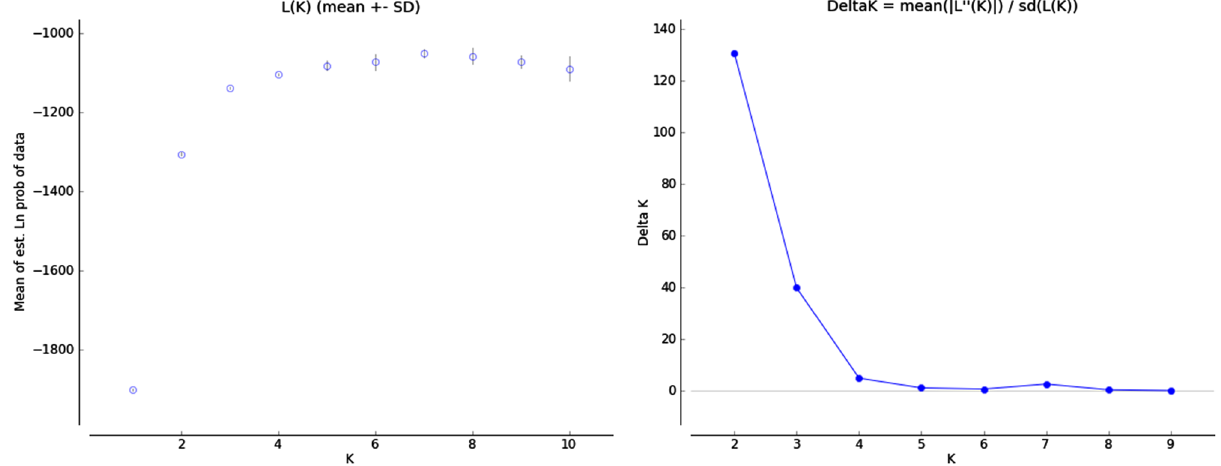
Figure 1. Modeling of cluster number for sweet potato using STRU CTU RE. L( K ) (left) and Delta K (right) were calculated in accordance with the method of Evanno et al. 28 .